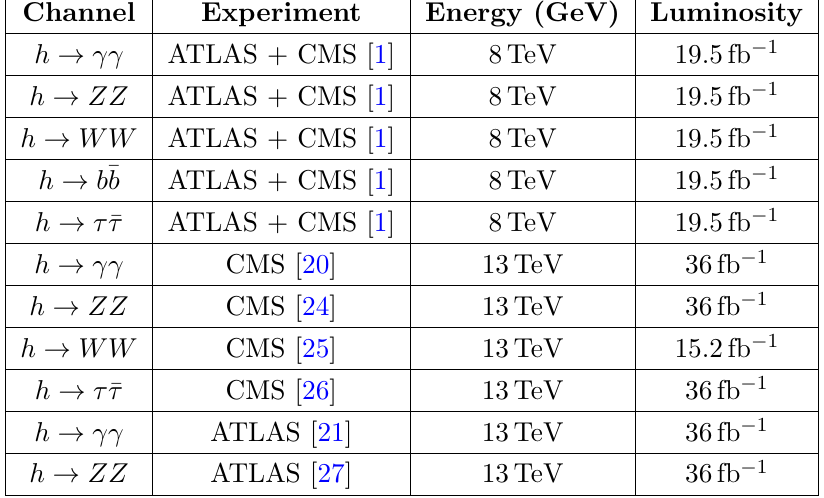
Table 3 . Listing of the Higgs signal strength measurements at LHC at 8 and 13 TeV.